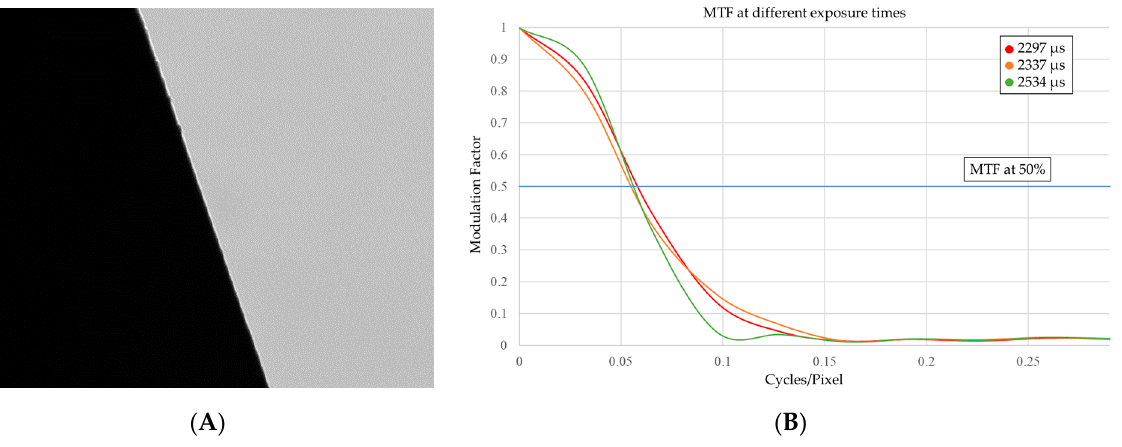
Figure 7. ( A ) Image of the sharp edge used as input; ( B ) MTF of the imaging system at different exposure times (the blue line is the MTF at 50%).